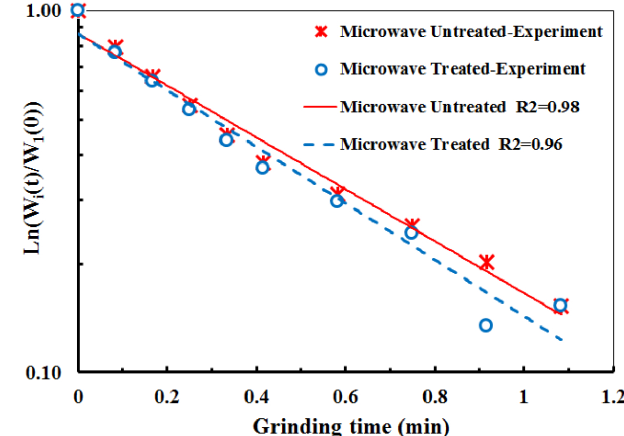
Fig. 6. The percentage oversized versus grinding time for batch dry grinding of feed -3350+2360 µm.